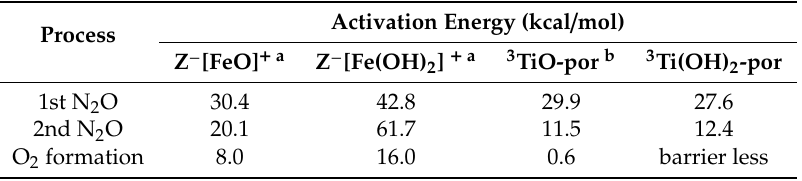
Table 2. Activation energy (kcal / mol) of the first and second N 2 O decompositions and oxygen formation over the Fe-ZSM5 and oxotitanium(IV)